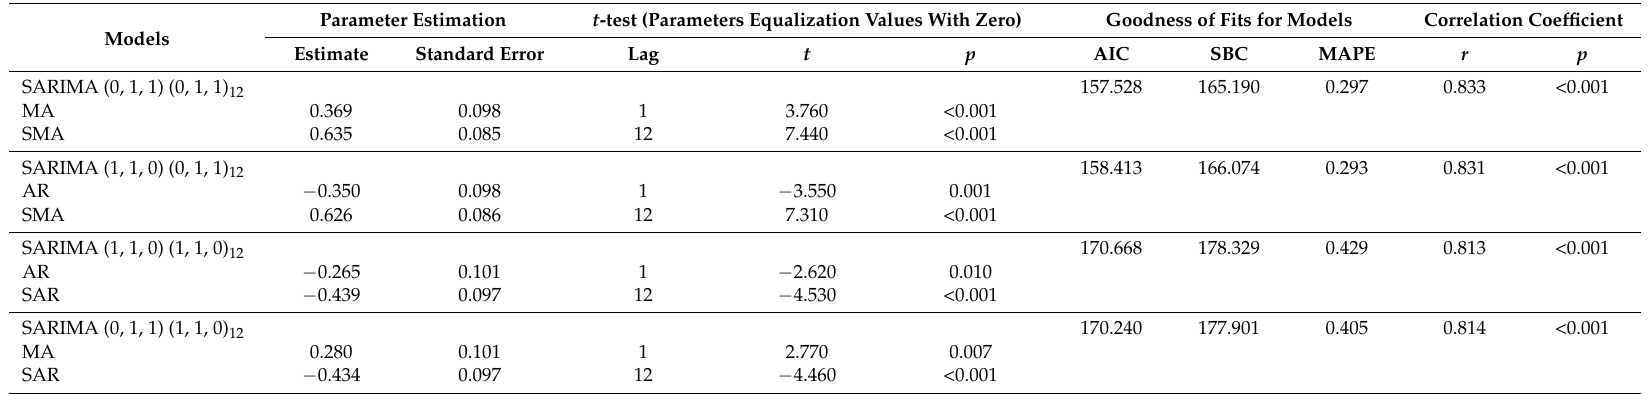
Table 1. Parameter estimates and testing results, goodness of fits for the seasonal autoregressive integrated moving average (SARIMA) models corresponding to different choices of p , q and P , Q which had gotten past parameter verification, as well as correlation analysis between actual and fitted mumps cases. Parameter Estimation t -test (Parameters Equalization Values With Zero) Goodness of Fits for Models Correlation Coefficient Models Estimate Standard Error Lag t p AIC SBC MAPE p